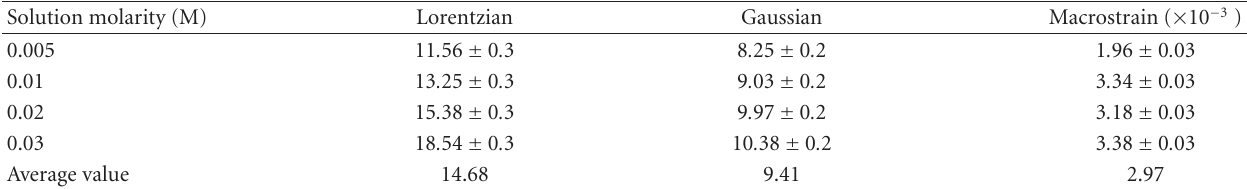
Table 1: The average crystallite size (nm) and macrostrain at di ff erent solution molarity (M) and kept constant substrate temperature of 450 ◦ C.